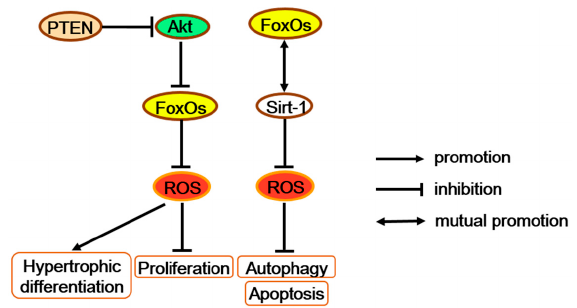
Figure 5. FoxOs increase antioxidants and further regulate multiple functions of chondrocytes. FoxOs possibly promote proliferation and block hypertrophic di ff erentiation along with the PTEN / Akt / FoxO signaling. FoxOs also repress apoptosis and autophagy with altering the SIRT-1 protein level. PTEN = phosphatase and tensin homolog deleted on chromosome